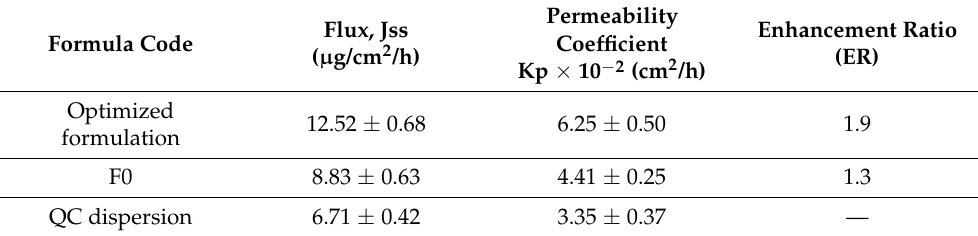
Figure 9. Cumulative amounts of QC deposited in the skin 8 h after application of the optimized formula, F0 and QC dispersion (mean values ± SD, n = 3).